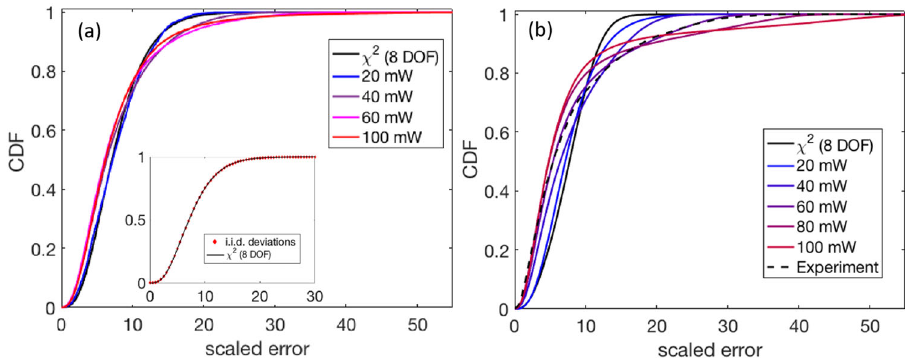
Fig. 3 Cumulative density function (CDF) representation of distributions of lattice fi tting displacement of the 6-particle system. Cumulative density function (CDF) representation of distributions of lattice fi tting of the 6-particle system in the local vicinity of the triangle con fi guration ( a ) and over the complete con fi guration space ( b ). The lattice fi tting displacement is the sum of squares of particle position deviations of a con fi guration from the stable triangle lattice sites minimized over all possible translations, rotations, and the lattice parameter. a The fi tting displacement computed from EDLD simulation trajectories of local fl uctuations in the vicinity of the triangle con fi guration deviates from the 8 degree of freedom χ 2 distribution that would be expected for particles executing uncorrelated i.i.d. Gaussian fl uctuations (black curve) indicating the presence of collective structural modes. The inset shows a control simulation in which i.i.d. Gaussian fl uctuations are imposed upon the particles (red diamonds) exactly follows the 8 DOF χ 2 distribution. The magnitude of the deviation of the CDF fi tting displacement distribution from the 8 DOF χ 2 distribution (solid black curve) increases with optical trapping power in simulations conducted over the range 20 – 100 mW, indicating that the collective motions become more signi fi cant (and increase in magnitude) at higher optical powers. The corresponding probability density functions are shown in Supplementary Fig. 2. b The fi tting displacement computed from EDLD simulation trajectories over the whole con fi guration space (i.e., not just local fl uctuations) of the 6-particle OM system deviates from the 8 degree of freedom χ 2 distribution. The magnitude of the deviation of the CDF fi tting displacement distribution from the 8 DOF χ 2 distribution (solid black curve) increases with optical trapping power in simulations conducted over the range 20 – 100 mW (solid colored curves) and experimental data gathered at an optical power of 50 mW (dashed black curve), indicating that the collective motions become more signi fi cant (and increase in magnitude) at higher optical